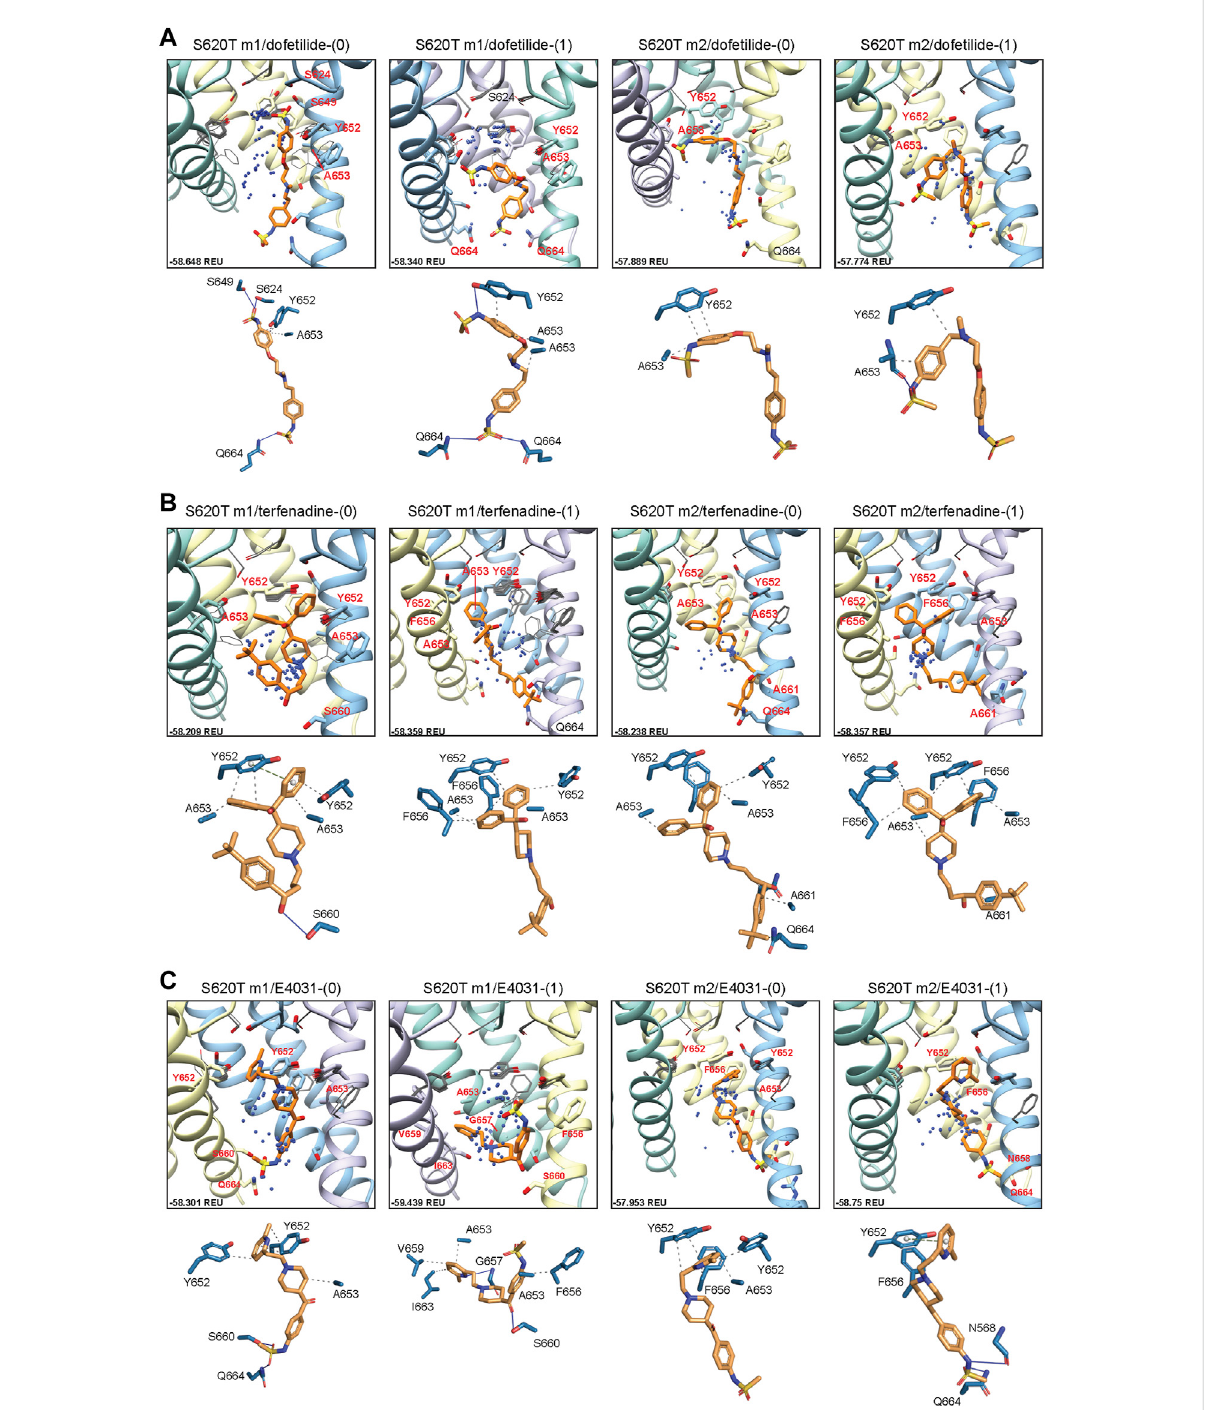
FIGURE 8 hERG S620T drug docking results for (A) dofetilide, (B) terfenadine and (C) E4031. Boxes represent top 50 scoring structures, with top-scoring structure as orange sticks (for carbon atoms) and remaining structures as blue centroids representing central nitrogen/charge group of the respective compound. Atoms, residues, and chains are shown and colored as in Figure 2. Rosetta ligand interface score for each top-scoring structure and PLIP for top-scoring poses are shown as in Figure